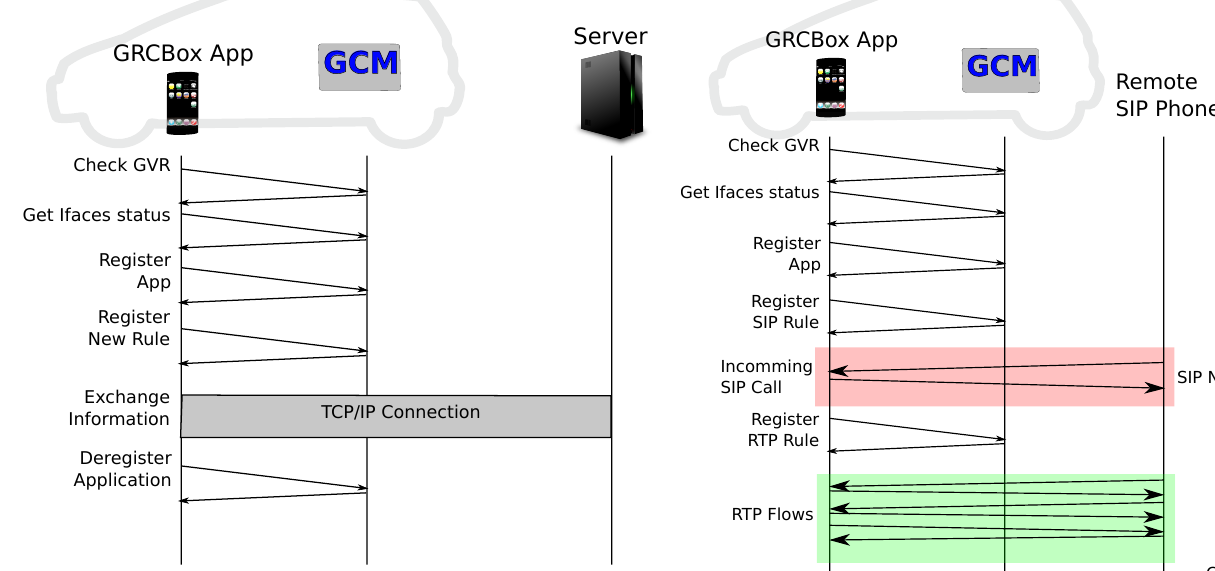
Figure 9: Example of a client GRCBox application con- necting to a server.